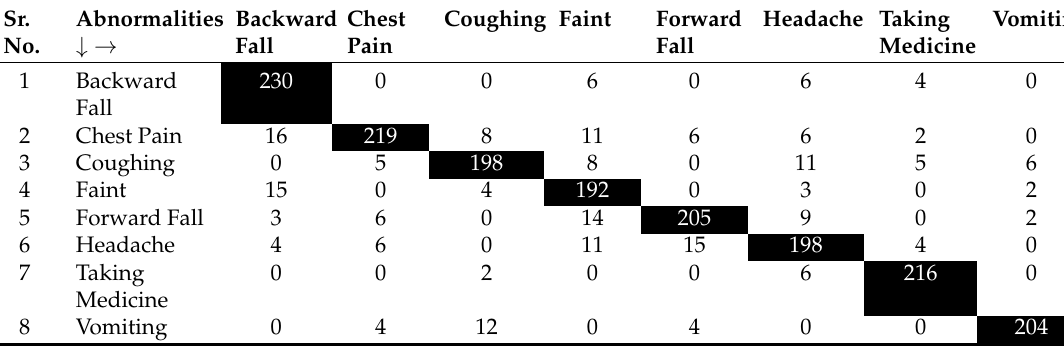
Table 7. Confusion matrix of dataset with the ratio of